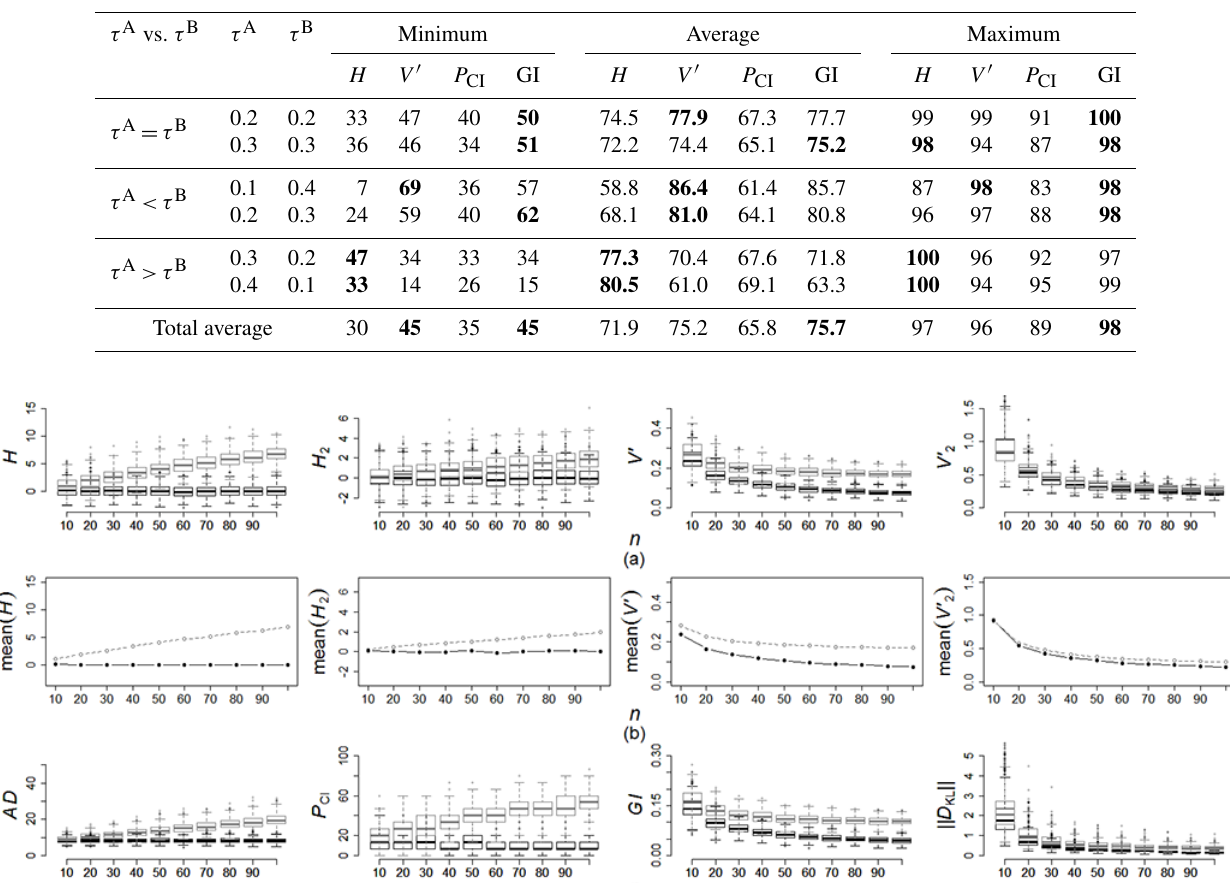
Table 2. Summary of the success rate (SR) minimum, average, and maximum of the considered measures ( H , V (cid:48) , P CI , and GI), expressed in percentage, when comparing the heterogeneity of two regions A and B. For a given τ A and τ B , such values are computed as the minimum, average and maximum of SR over 48 cases, respectively. For each case, SR is obtained as the mean over N s = 500 simulations of two regions with n = 30 and given N A , N B , γ A , and γ B . Values in bold indicate the measure obtaining the largest SR minimum, SR average, and SR maximum, respectively.